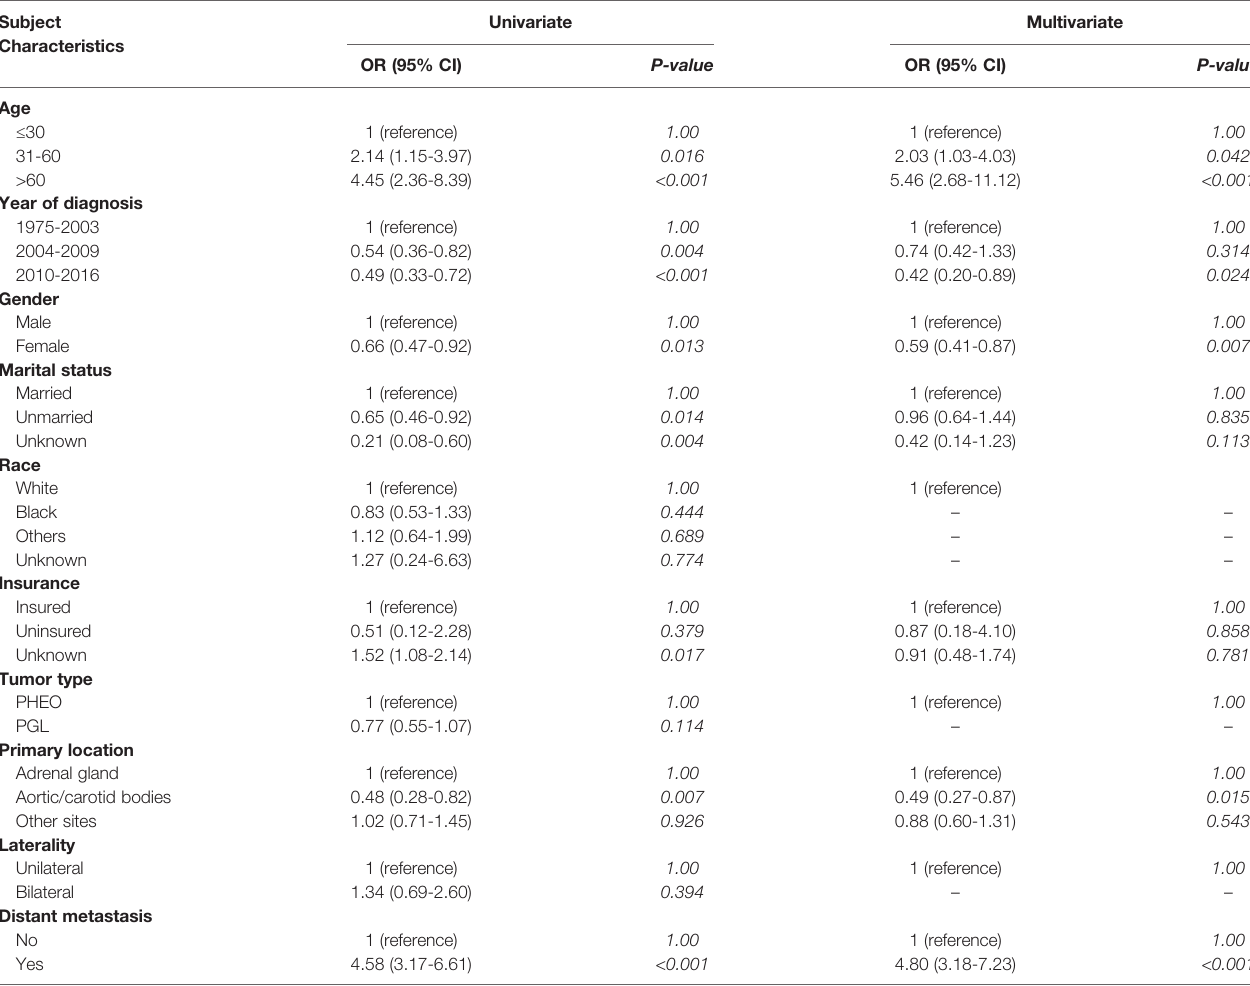
TABLE 2 | Logistic regression model for analyzing the risk factors for early death in patients diagnosed with pheochromocytoma and